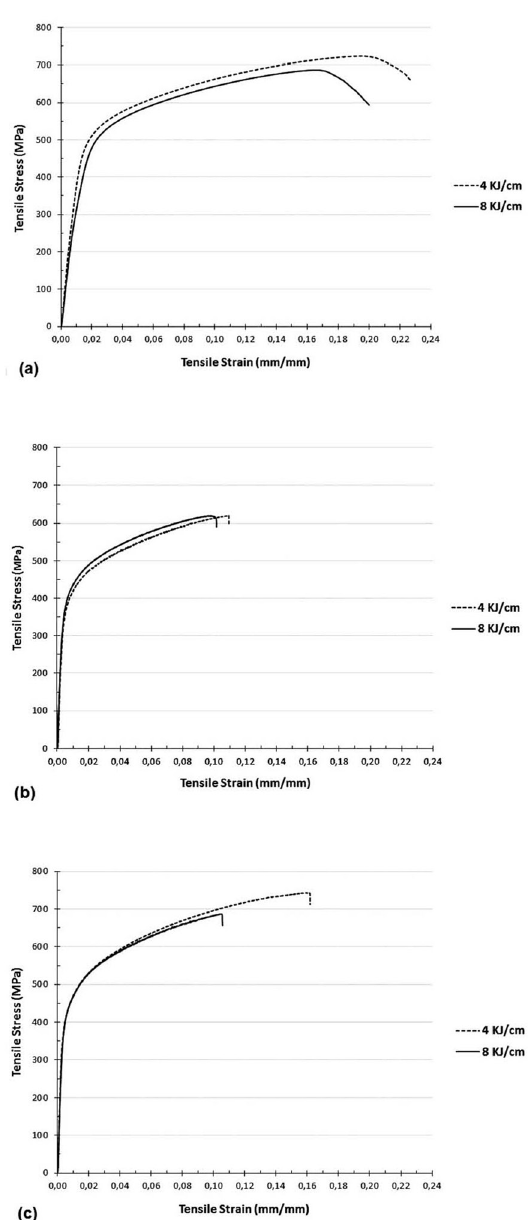
Figure 10. Stress-strain curve of tests performed on weldments with AWS ER2209 (a) without AHT, (b) with 50 h of AHT, and (c) with 100 h of AHT.